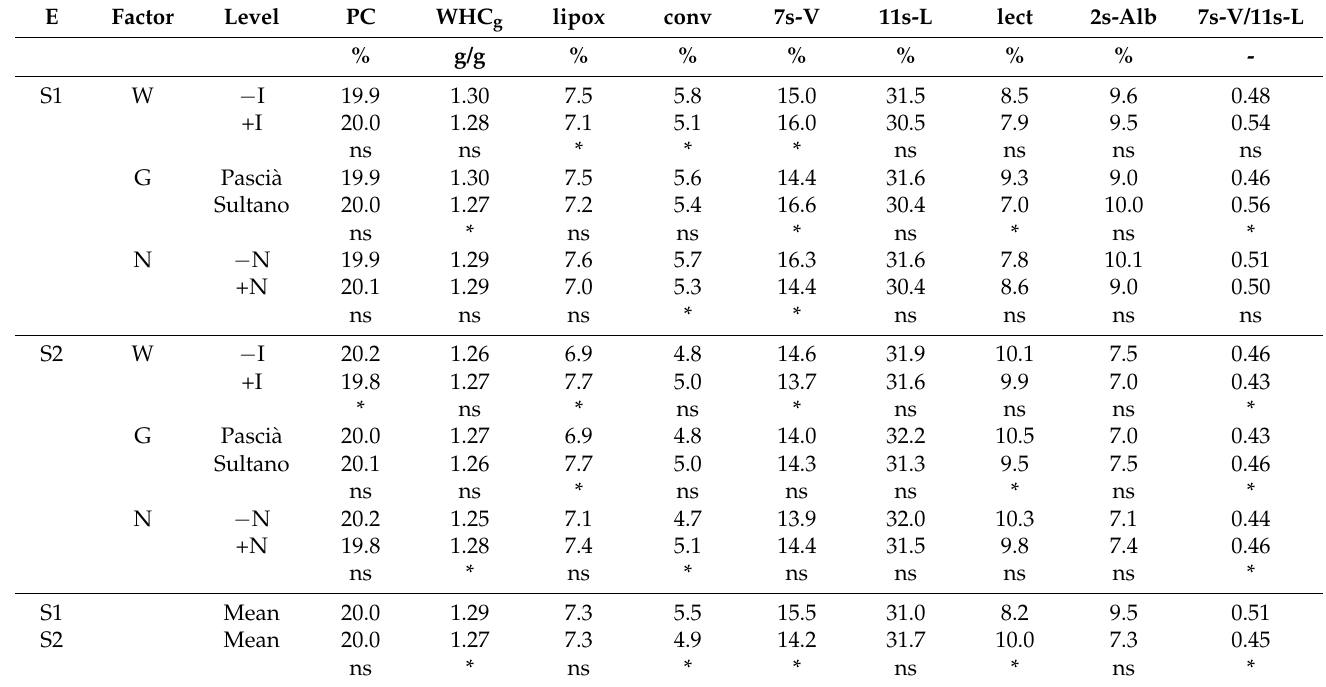
Table 7. Protein content, grain water-holding capacity, and protein composition of Pasci à and Sultano chickpea varieties grown under two water regimes and two N